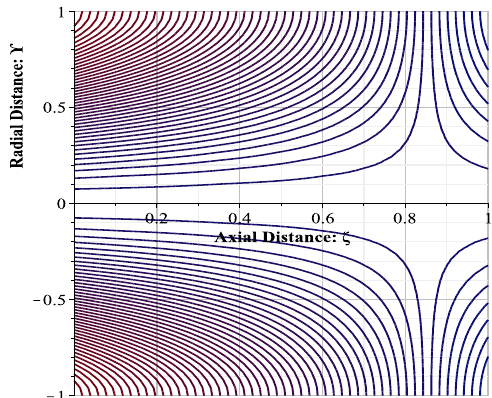
Figure 11. Stream lines for W RE = 1.5 × 10 − 5 .